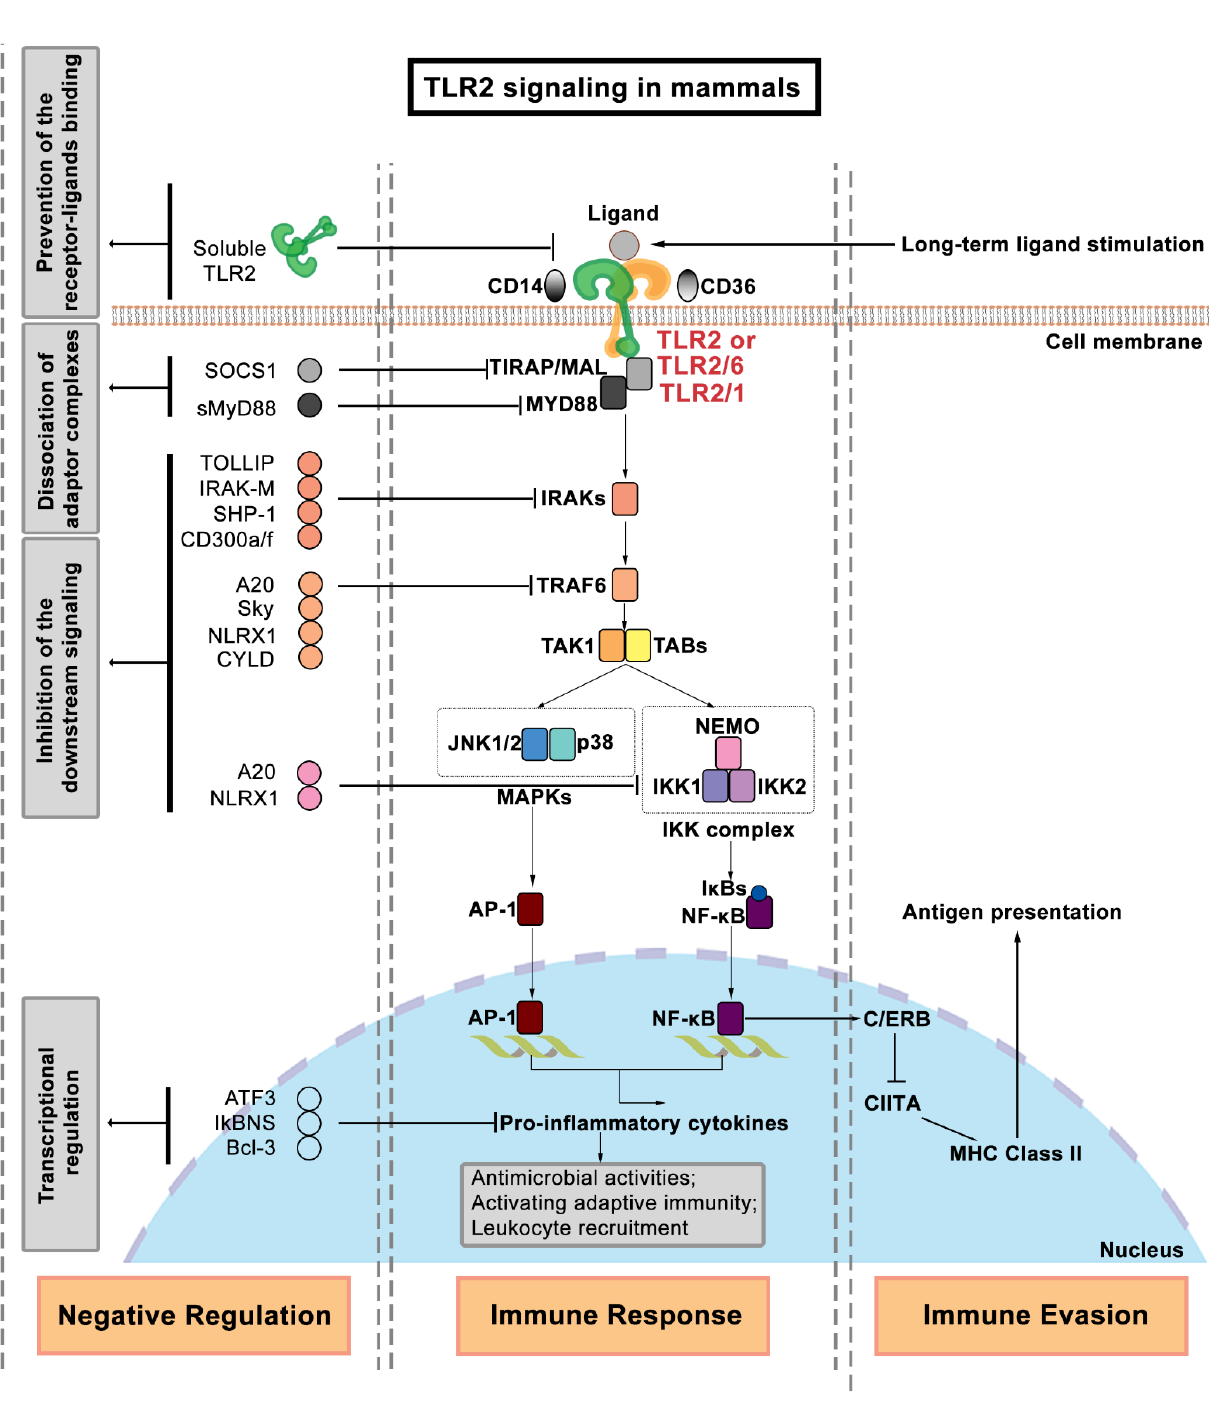
Figure 3. A brief overview of the TLR2 signaling pathway in mammals [39,62]. TLR2 or its heterodimers are located on the cell membranes. The TLR2 signaling activation through TLR2/1 requires the participant of accessory molecule CD14, while TLR2/6 requires CD36. The TLR2 signaling pathway is activated after TLR2 ligand recognition (PAMPs or DAMPs). Subsequently, the adaptor proteins, MYD88 and TIRAP/MAL, are recruited. After a series of cascades involving NF- κB and MAPKs, various transcription factors are activated to induce pro-inflammatory cytokines. Of note, the shown TLR2 signaling components are not exclusive for this TLR receptor, and the phosphorylation and ubiquitination processes are not mentioned in this Figure. The expansion of gene symbols and more gene information can be found in the HUGO Gene Nomenclature Committee website (HGNC, www.genenames.org) or the Mouse Genome Database (MGD,